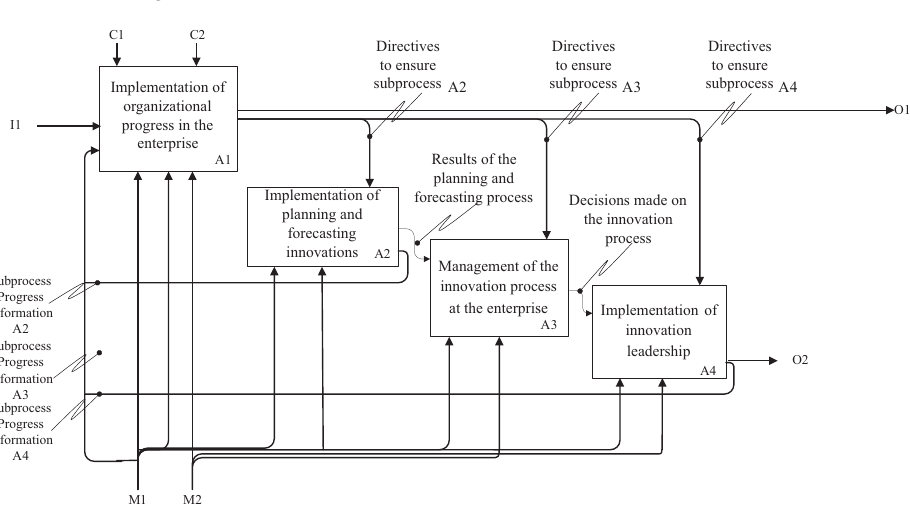
Figure 3. The main decomposition of the functional model and graphic representation of the process of managing the innovative activity of an enterprise in the conditions of economic development I – represents input information or a specific input element. In our case, these are just 1